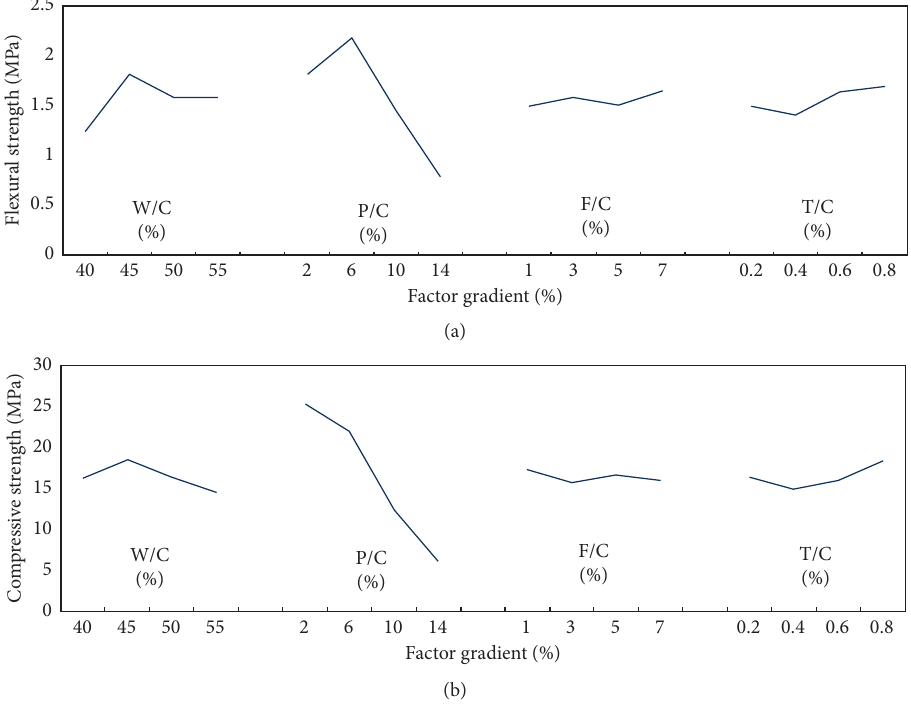
Figure 10: Influence factor diagram. (a) Flexural strength factor influence diagram. (b) Compression strength factor influence